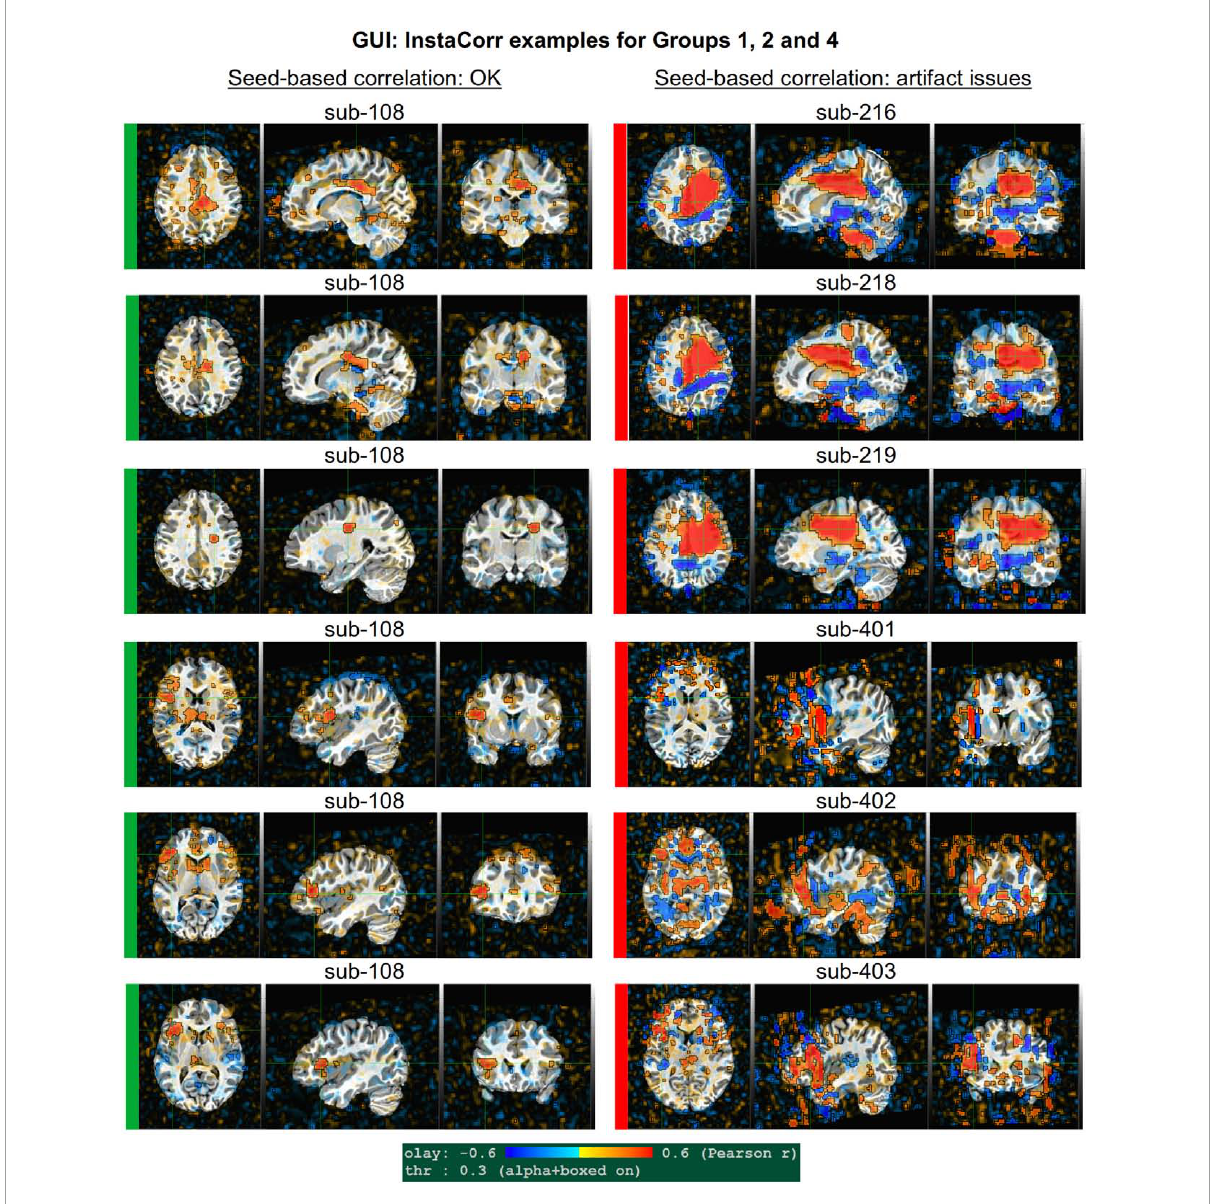
FIGURE10 GUI examples of QC, using AFNI’s InstaCorr: This provides deeper understanding of the spatiotemporal patterns of the data through interactive driving of seed-based correlation. Several subjects in Groups 2 and 4 had difficult to interpret APQUAL QC results, particularly in seed-based correlation maps (vstat); upon further inspection here, it was apparent that those subjects contained large artifacts within the EPI datasets, as evinced by large correlation/anticorrelation patterns from seed locations in deep WM (Group 2) and extensive, non-physiological correlation/anticorrelation patterns from frontal GM/WM seeds (Group 4). In the end, these artifacts appeared to be present in all subjects of these groups, so that all were categorized for